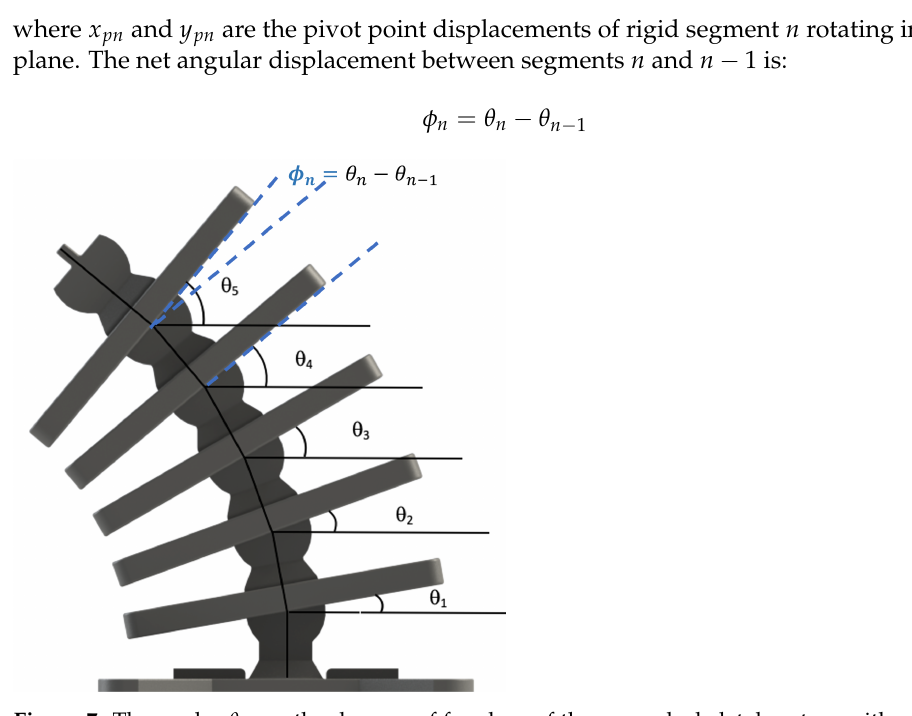
Figure 7. The angles θ n are the degrees of freedom of the musculoskeletal system with respect to the horizontal axis. The bottom rigid segment is fixed. The angle φ n is the displacement between segments n and n − 1.